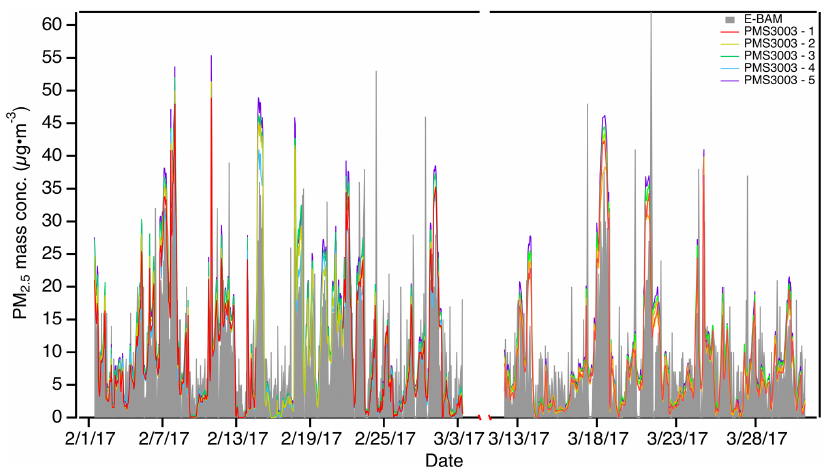
Figure 3. Comparison of hourly PM 2 . 5 mass concentrations between the E-BAM and the five uncalibrated PMS3003 sensor packages between 1 February and 31 March 2017 at Duke